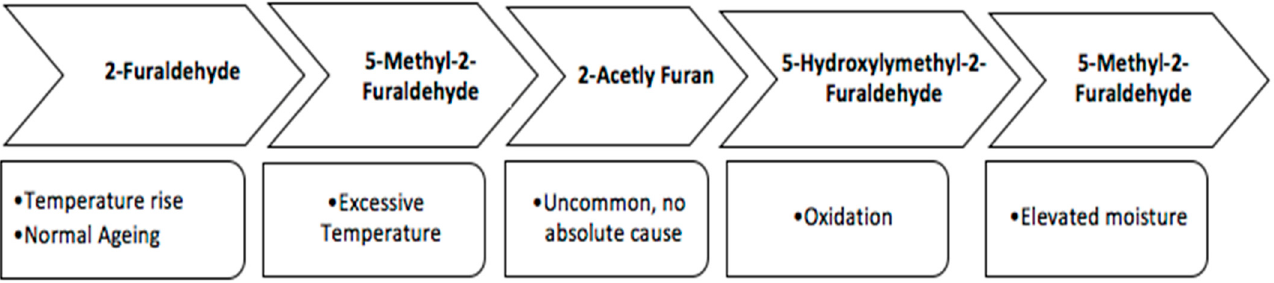
Figure 1. Sources of Furanic compound generation [22].